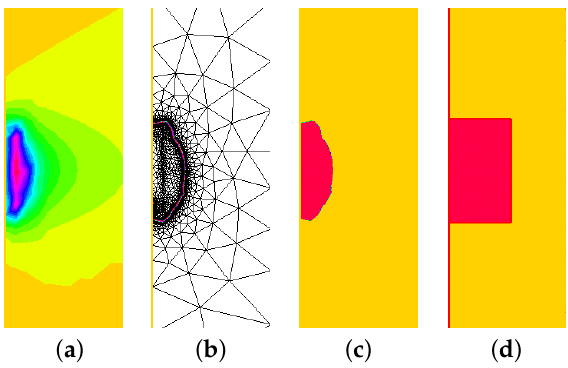
Figure 2. Plot of the ( a ) Linear Sampling solution, ( b ) the cut-off of 75%, ( c ) the finite element mesh adaptation for the cut-off solution, and the ( d ) final two colored solutions that forms the best image representation of the clogging